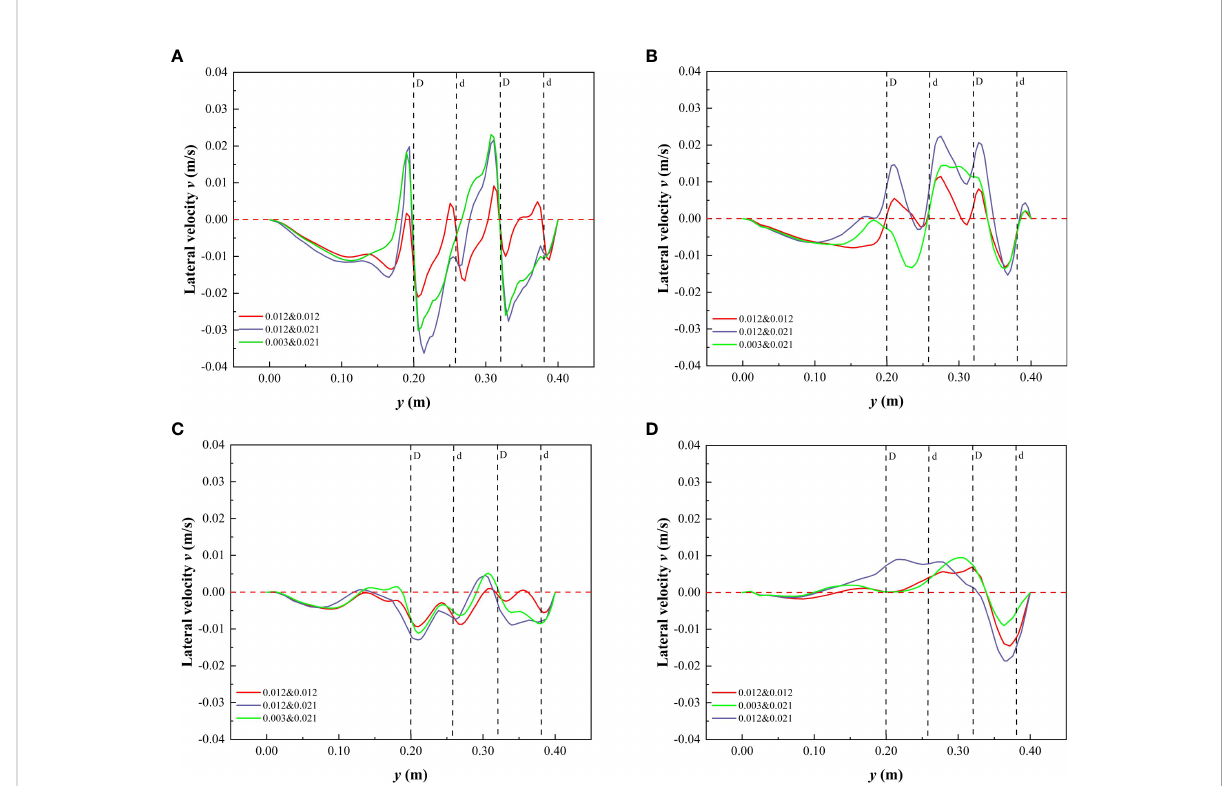
FIGURE 8 Variation of lateral velocity in cross-section at h of 0.06 m and 0.10 m under different submerged conditions. (A) C 2 , h = 0.06 m, non- submerged vegetation, (B) C 2 , h = 0.10 m, submerged vegetation, (C) C 3 , h = 0.06 m, non-submerged vegetation, (D) C 3 , h = 0.10 m, submerged